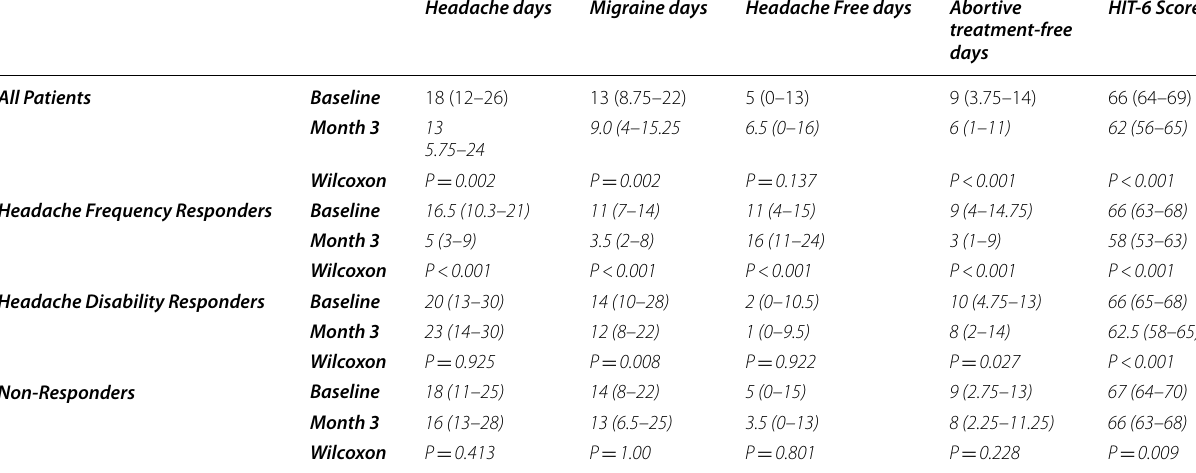
Table 3 Clinical characteristics of all patients using single‑pulse transcranial magnetic stimulation ( N responders and ( N 48), headache disability responders ( N =